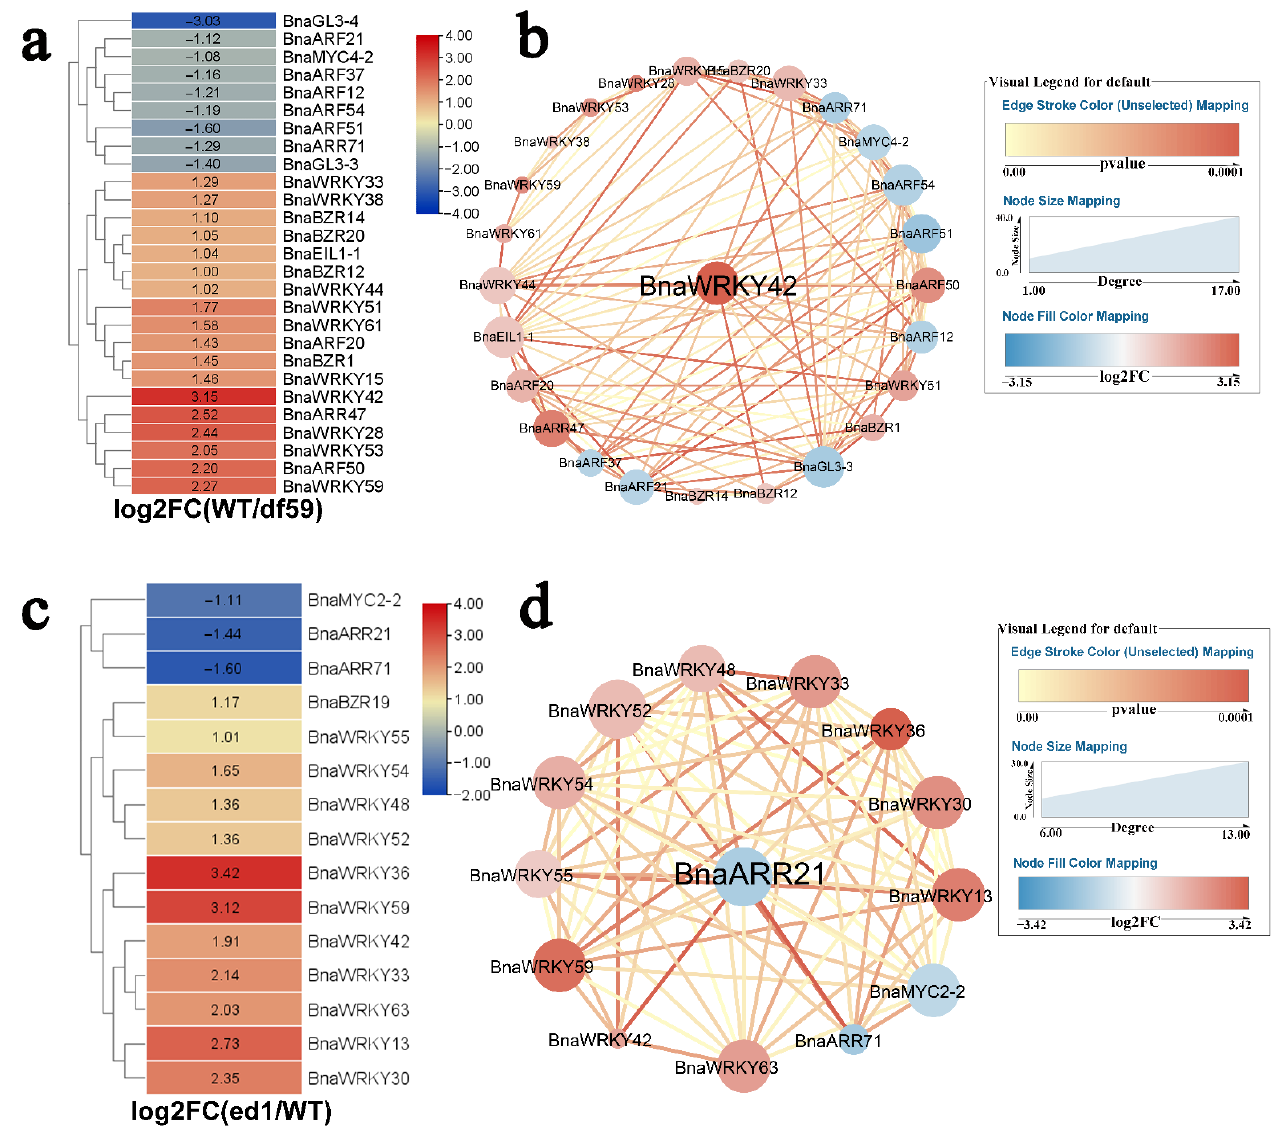
Figure 3. Expression profiles of B. napus hormone-related TFs in response to PH. Cycle nodes represent genes and the size of the node represents the power of the inter-relationship among nodes by degree value; Color of the node represents log2FC value; Red indicates up-regulated genes and blue indicates down-regulated genes; Edges between nodes represent p -value. ( a ) Expression analysis of B. napus hormone-related TFs in a conventional rapeseed cultivar (Ningyou 18) and a dwarf mutant (df59). ( b ) Co-expression network analysis of differentially expressed B. napus hormone-related TFs in WT and df59. ( c ) Expression analysis of hormone-related TFs in an extreme dwarf mutant of rapeseed (ed1) and WT. ( d ) Co-expression network analysis of differentially expressed B. napus hormone-related TFs in ed1 and WT.